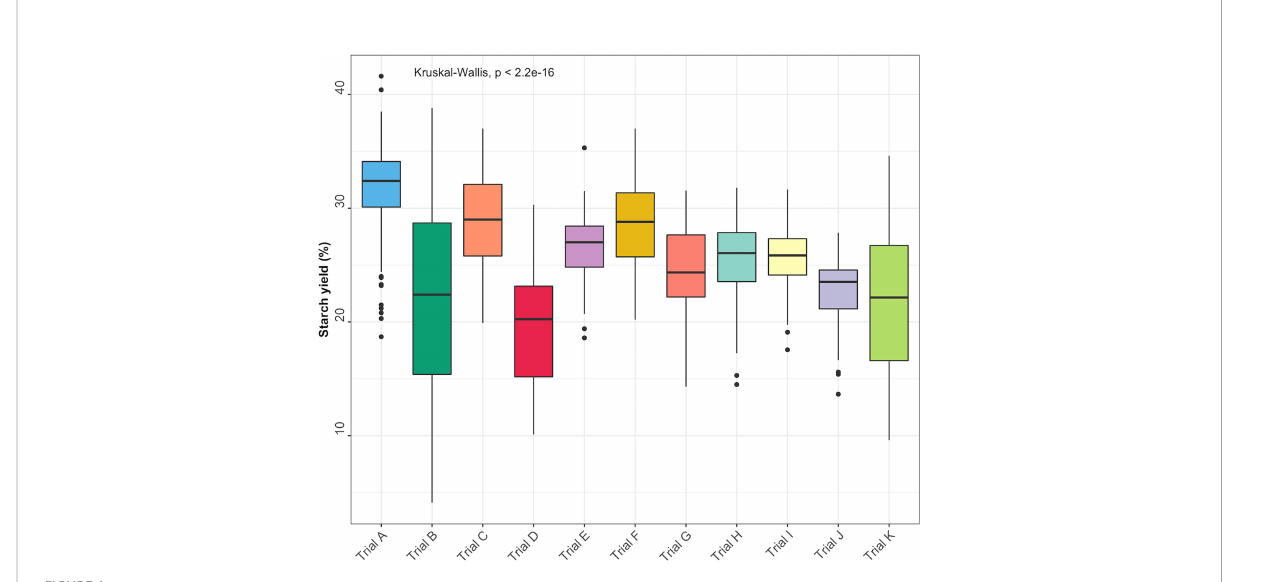
FIGURE 1 Root starch content distributions for the 11 evaluated cassava